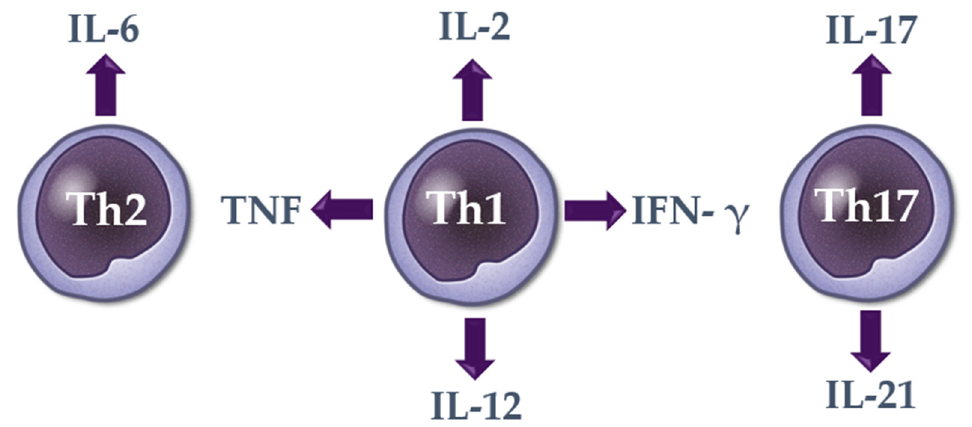
Figure 1. Systemic cytokines in alopecia areata. The role of the serum IL-18, IL-4, IL-5, IL-9, IL-10, IL-13, IL-17E, IL-17F, IL-21, IL-22, IL-23, IL-31, IL-33, and TGF- β has been indicated. Graphic by J. Taczała, MSc.